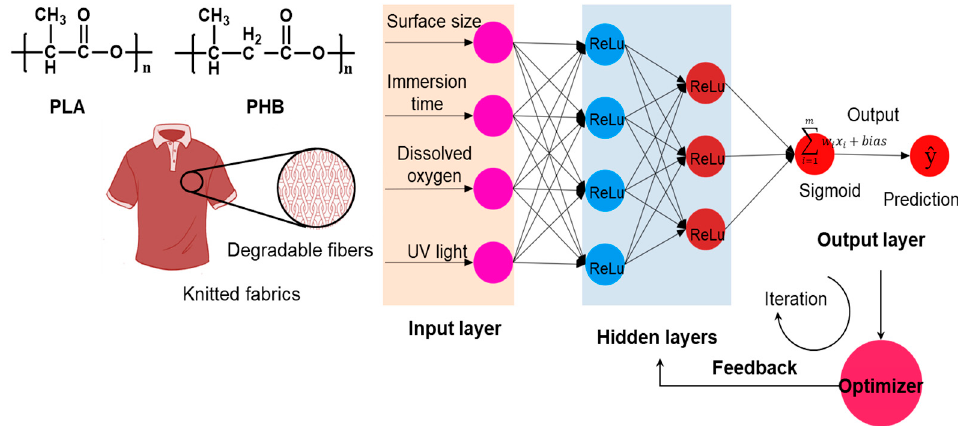
Figure 2. Schematic illustration showing the lifetime prediction by experimental data processing based on the artificial neural network (ANN) model.